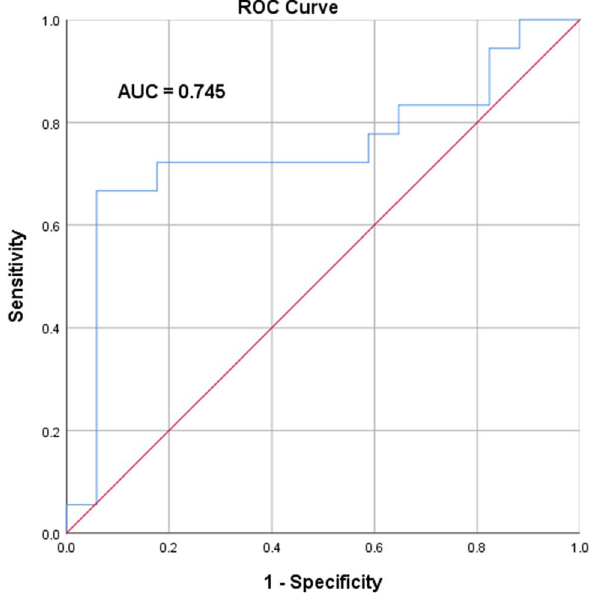
Fig. 15 Receivers operating characteristic (ROC) curve of Kangsabati River basin showing the accuracy of the present study